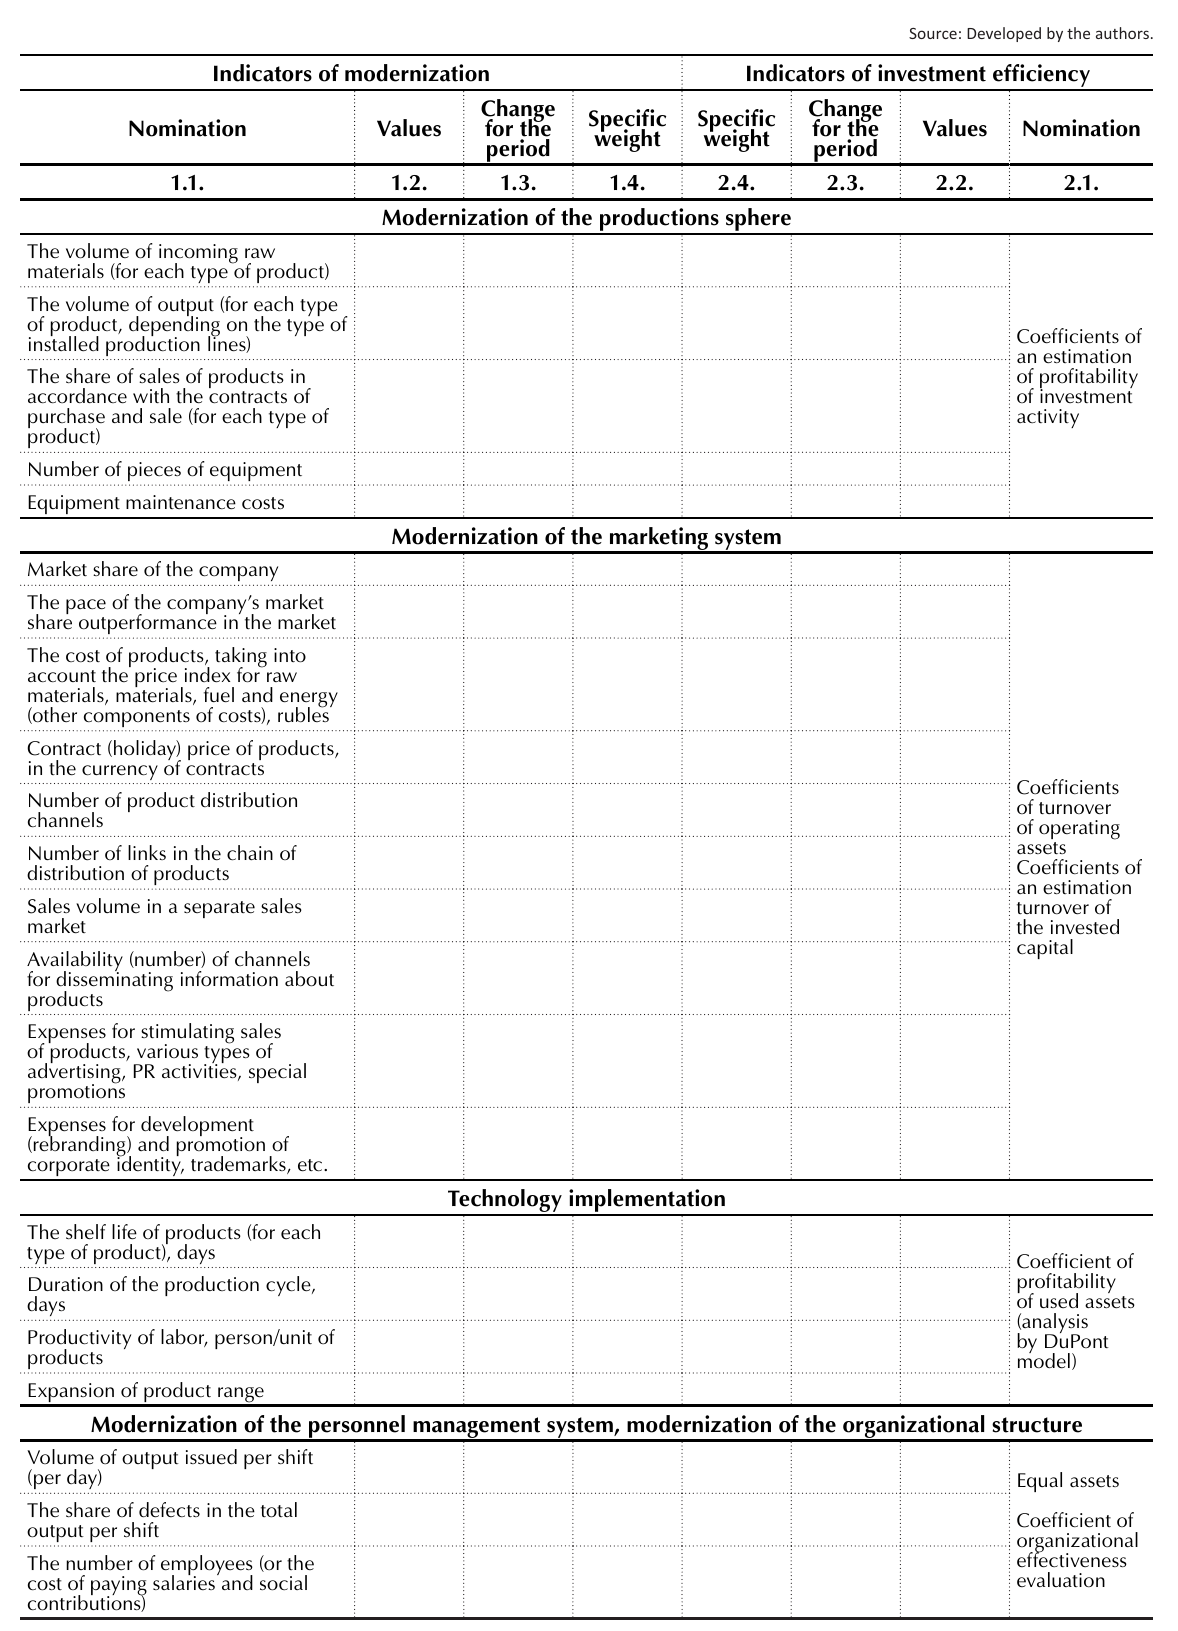
Table 1. The matrix of balanced indicators of the effectiveness of investment activities for the modernization of enterprises